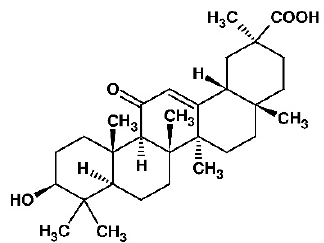
Figure 1. Chemical structure of 18 β -glycyrrhetinic acid (18 β -GA).